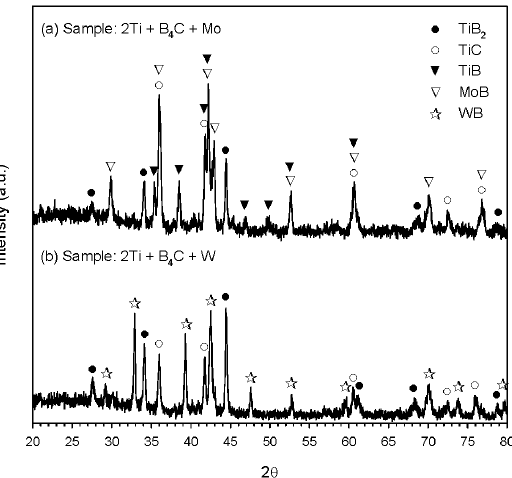
Figure 5. XRD patterns of SHS-derived composites from samples with stoichiomerties of ( a ) 2Ti + B 4 C + Mo and ( b ) 2Ti + B 4 C + W.